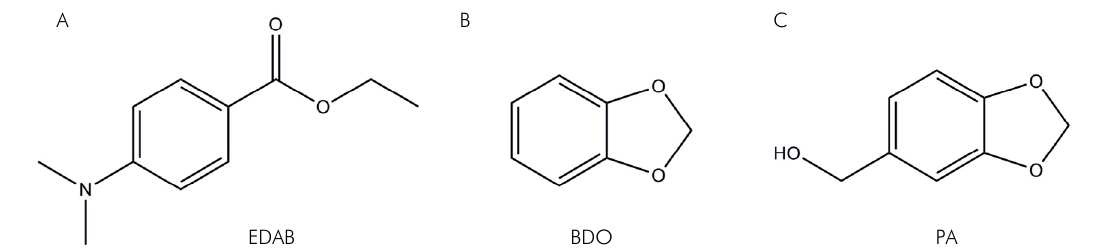
Figure 1. Molecular structure of the co-initiators used in the present study.